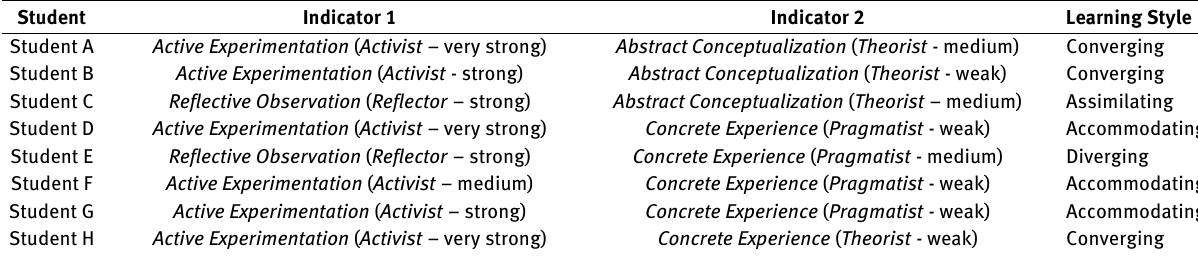
Table 1: Participating students’